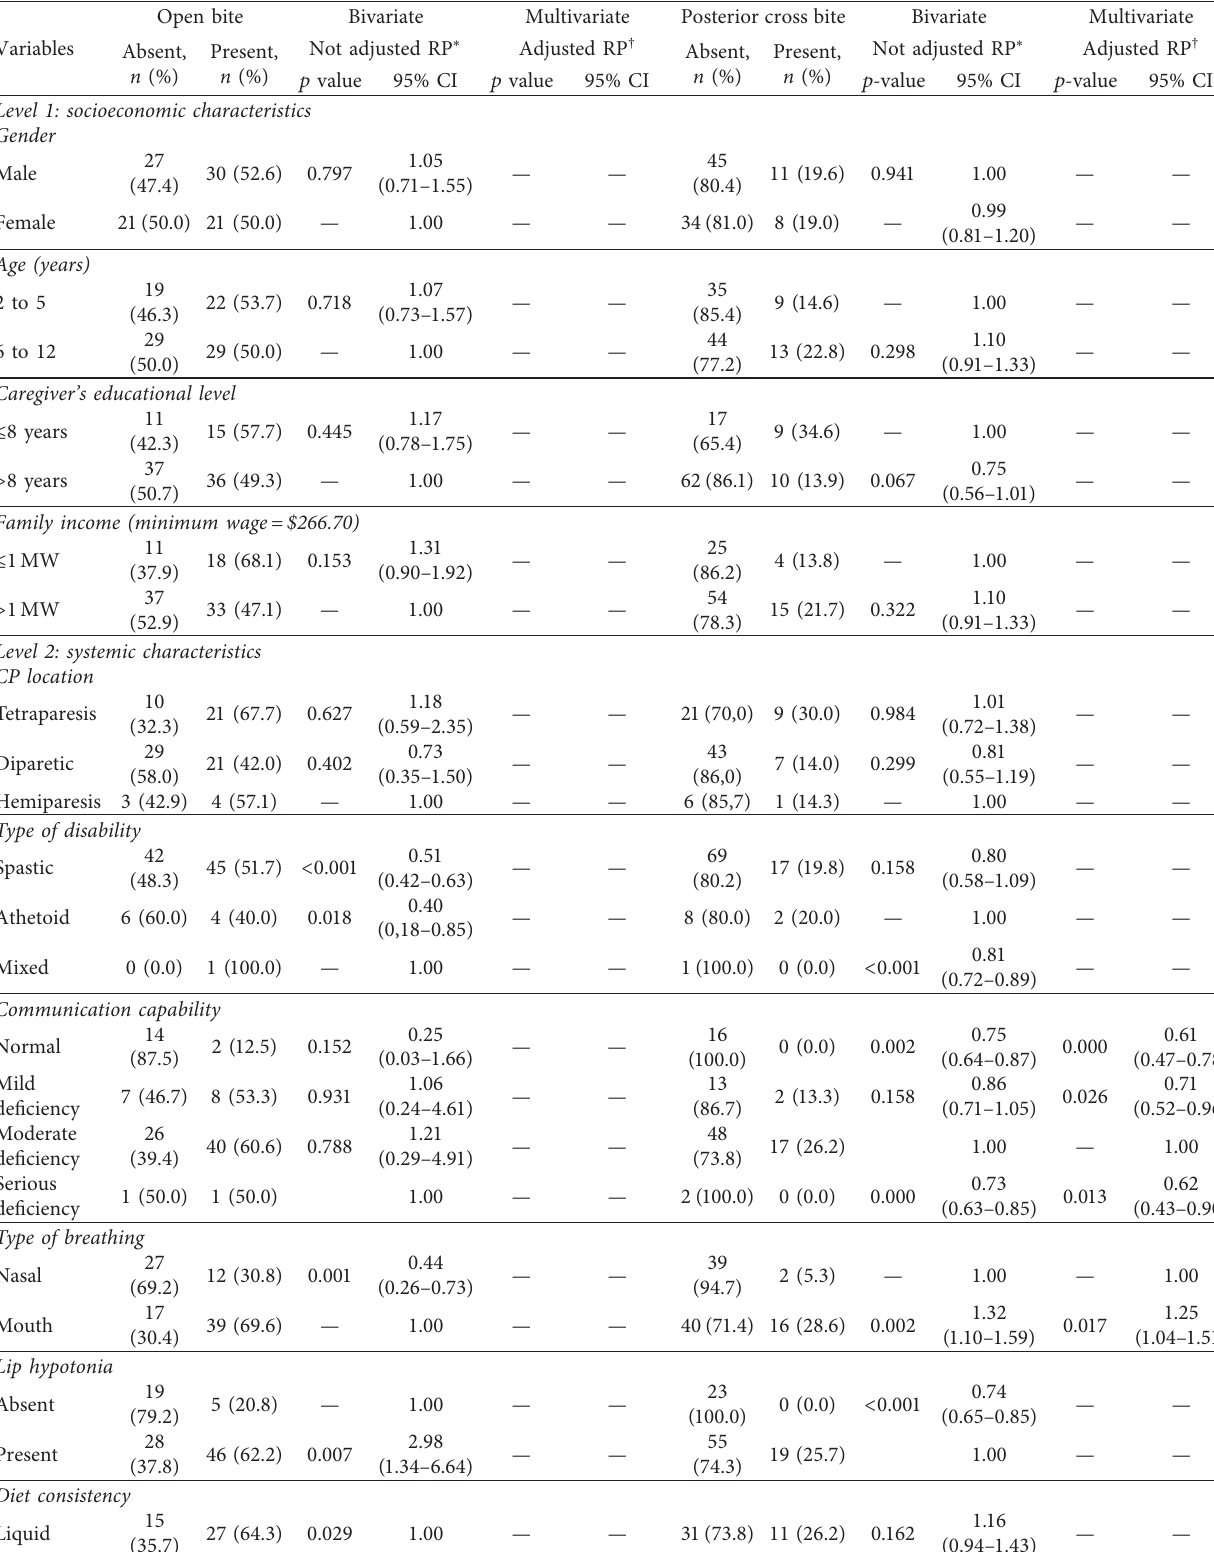
Table 3: Distribution of children and adolescents with CP in Poisson bivariate and multivariate regression models for the presence of open bite and posterior cross bite and independent